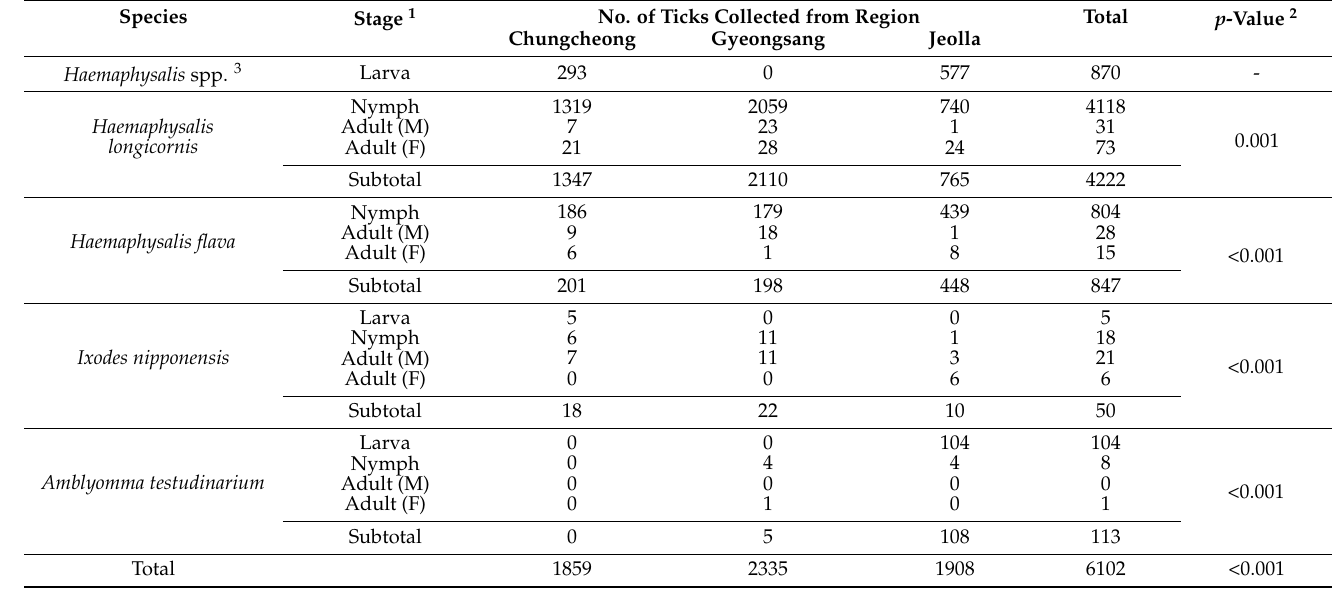
was positive. Out of 526 pools containing 4222 H. longicornis ticks, 2 pools (0.05% MIR) were positive. Regional prevalence were 4.6%, 1.6%, and 0.9% of the GS, JL, and CC region pools, respectively. Borrelia infection was confirmed in all three regions of Ixodes ticks: 65.0% in the GS region, 20.0% in the JL region, and 15.4% in the CC region. In sexes, the prevalences were 10% and 3.2% in the adult males and females, respectively. Table 1. Distribution of tick species based on region and developmental stage.